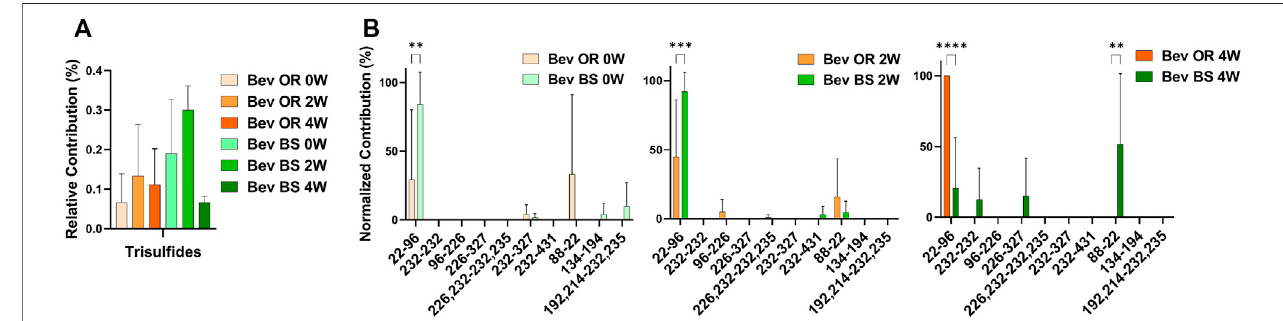
FIGURE4| Trisul fi debondsdetectedforbevacizumabsamplesbyLC-MS/MS. (A) Totaltrisul fi debondcontributionrelativetotheXICsumofallidenti fi eddisul fi de bondsforbevacizumabOR(0 week — peach,2 weeks — orange,4 weeks — redorange)andBS(0 week — teal,2 weeks — green,4 weeks — darkgreen). (B) Prevalence of the shuf fl ed bond locations normalized to the total number of shuf fl ed bonds for bevacizumab OR (0 week – peach, 2 weeks — orange, 4 weeks — red orange) and BS (0 week — teal, 2 weeks — green, 4 weeks — dark green) ( N = 3, mean ± SD, 2-way ANOVA, * p < 0.05, ** p < 0.01, *** p < 0.001, **** p < 0.0001).